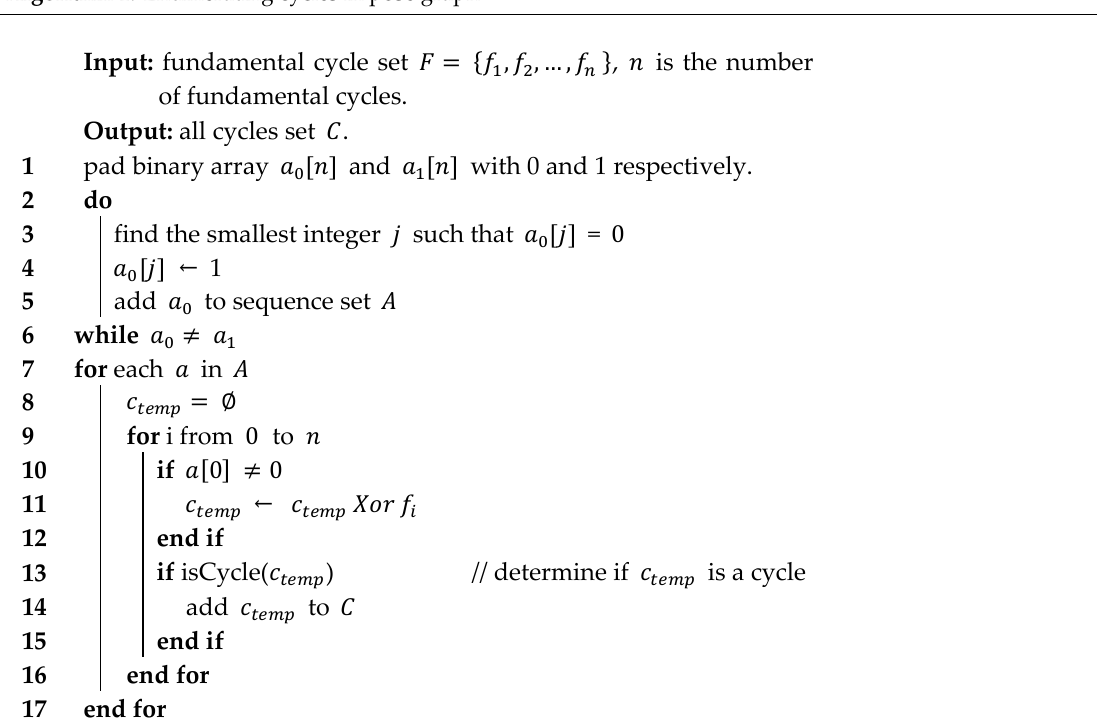
Algorithm 2: Cycle based error edge elimination